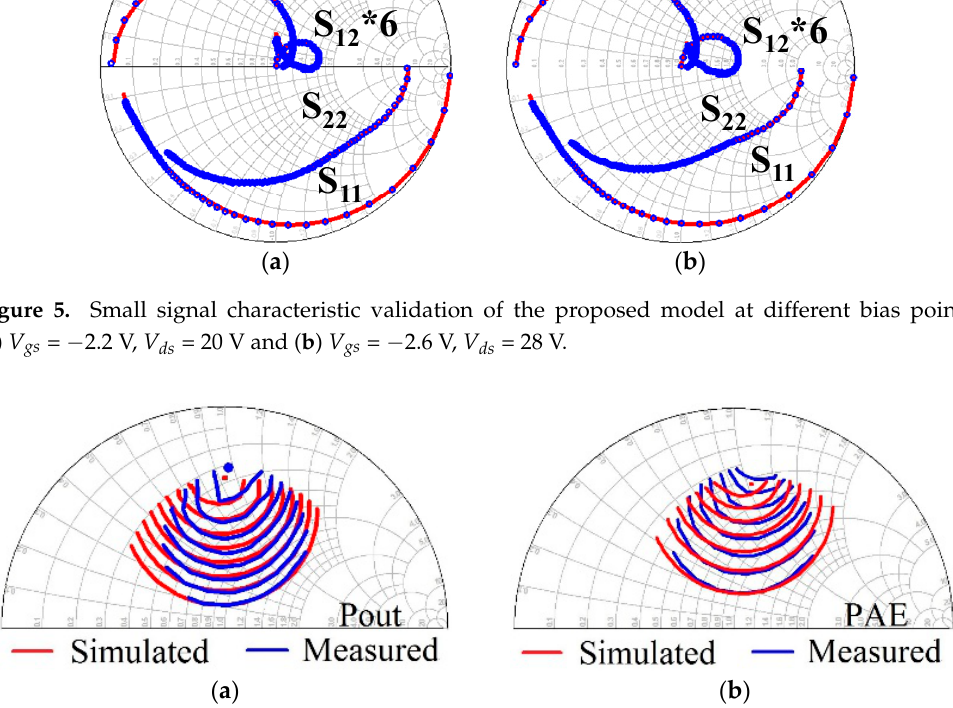
Figure 6. Validation of the impedance contours of the proposed model: ( a ) Impedance contour for maximum output power and ( b ) Impedance contour for maximum PAE.